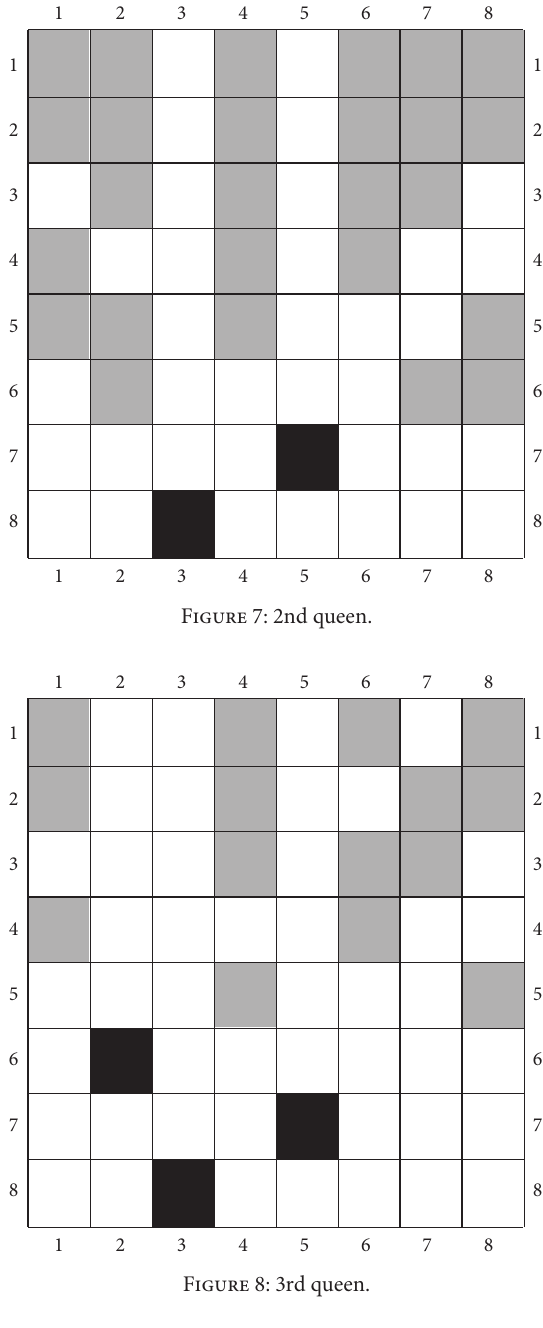
Figure 6: 1st queen.